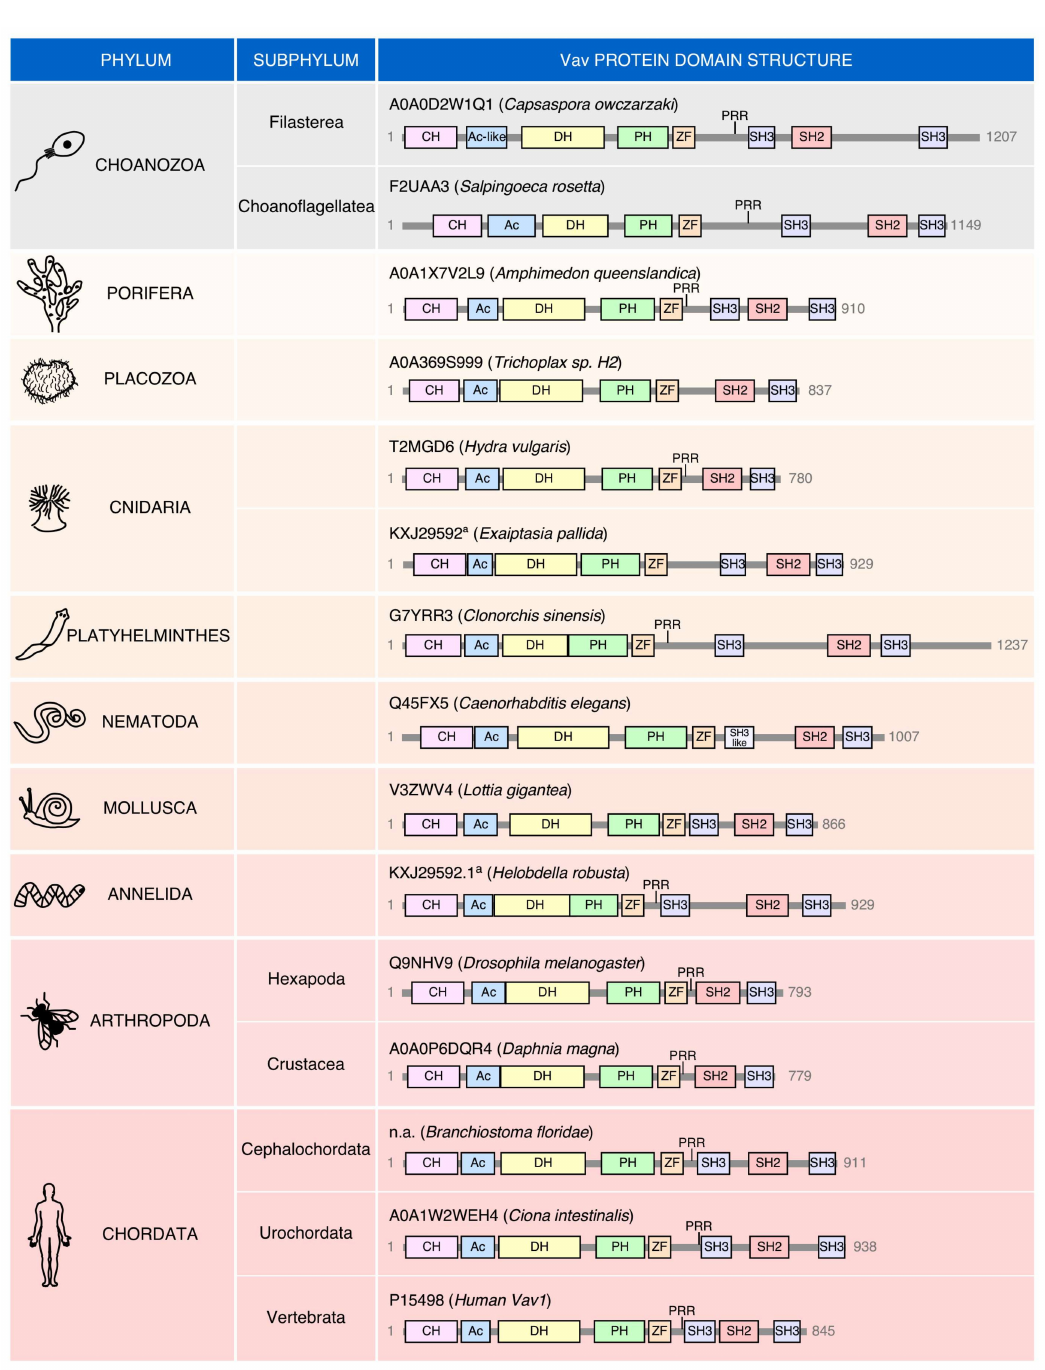
Figure 2. Evolution of the “body plan” of Vav family proteins. Depiction of the structure of Vav proteins in representative organisms of both the choanozoan (in gray) and metazoan (salmon-color gradient) phyla. UniProt accession codes are indicated for each